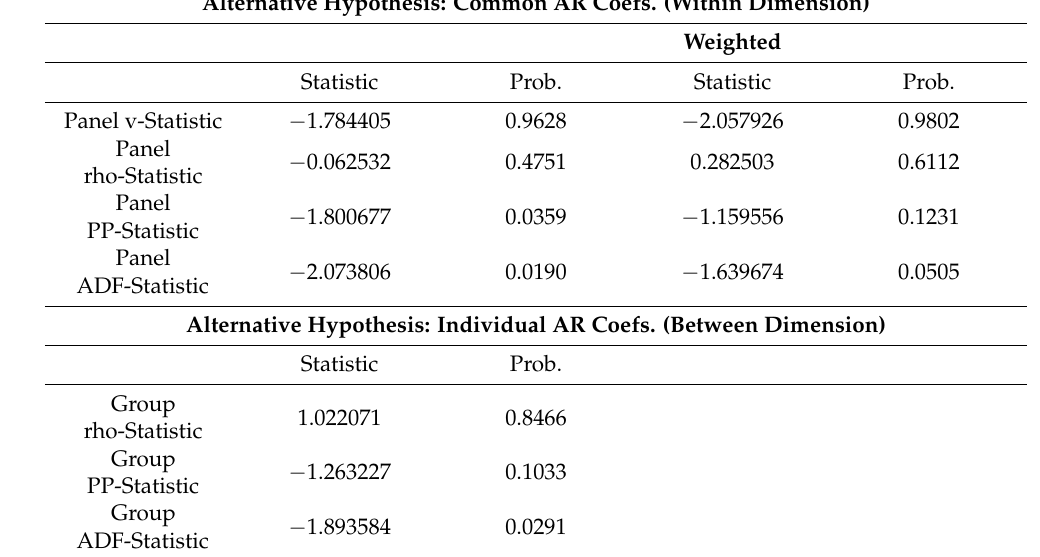
Table 4. Panel Pedron cointegration